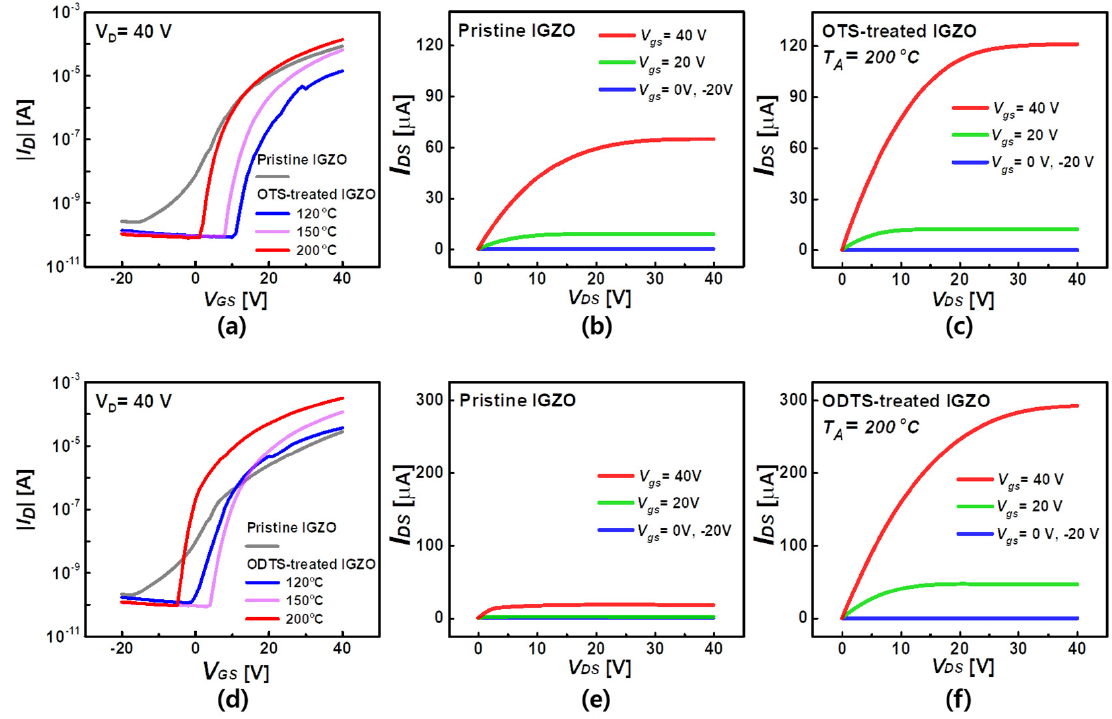
Figure 3. Transfer curve based on the annealing temperature of OTS–treated ( a ) and ODTS–treated transistors ( d ); Pristine output curve of OTS–treated ( b ) and ODTS–treated transistors ( e ); Output curve of OTS–treated ( c ) and ODTS–treated transistors ( f ) according to annealing (T A = 200 ◦